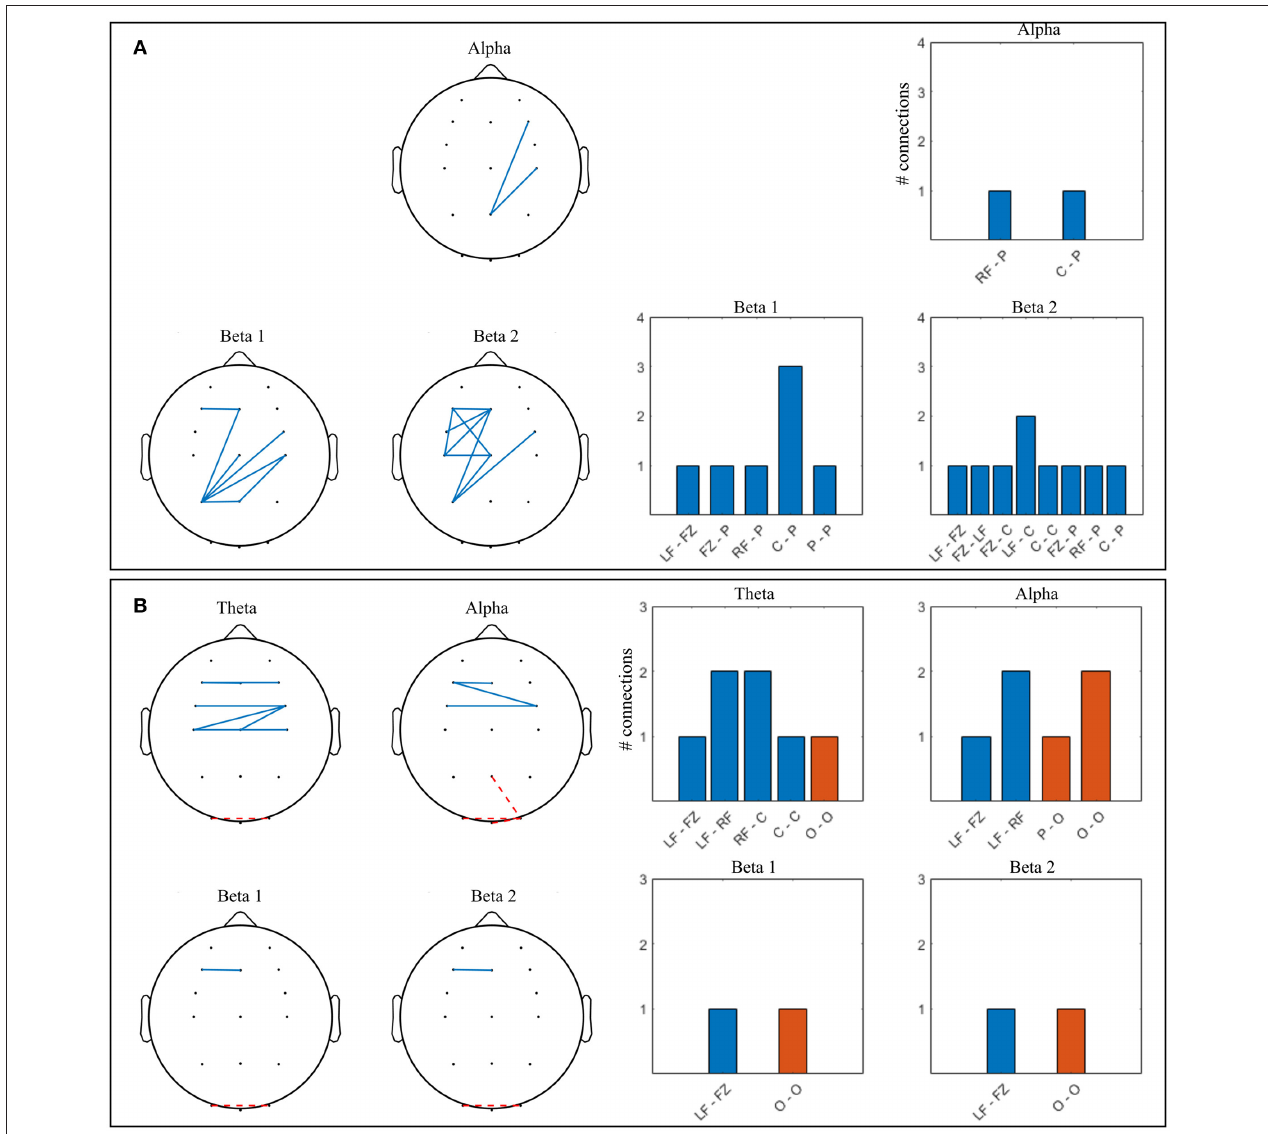
FIGURE 11 | Significant connections in competitive gaming vs. baseline grand average ( p < 0.01, FDR corrected); theta = 4–7Hz, alpha = 8–12Hz, beta 1 = 13–20Hz, beta 2 = 21–30Hz. (A) winners (W), (B) losers (L). Grouped locations: LF, left frontal; RF, right frontal; C, central; P, parietal; O, occipital and topographical plots. Blue, continuous, increase from baseline; orange, dashed, decrease from